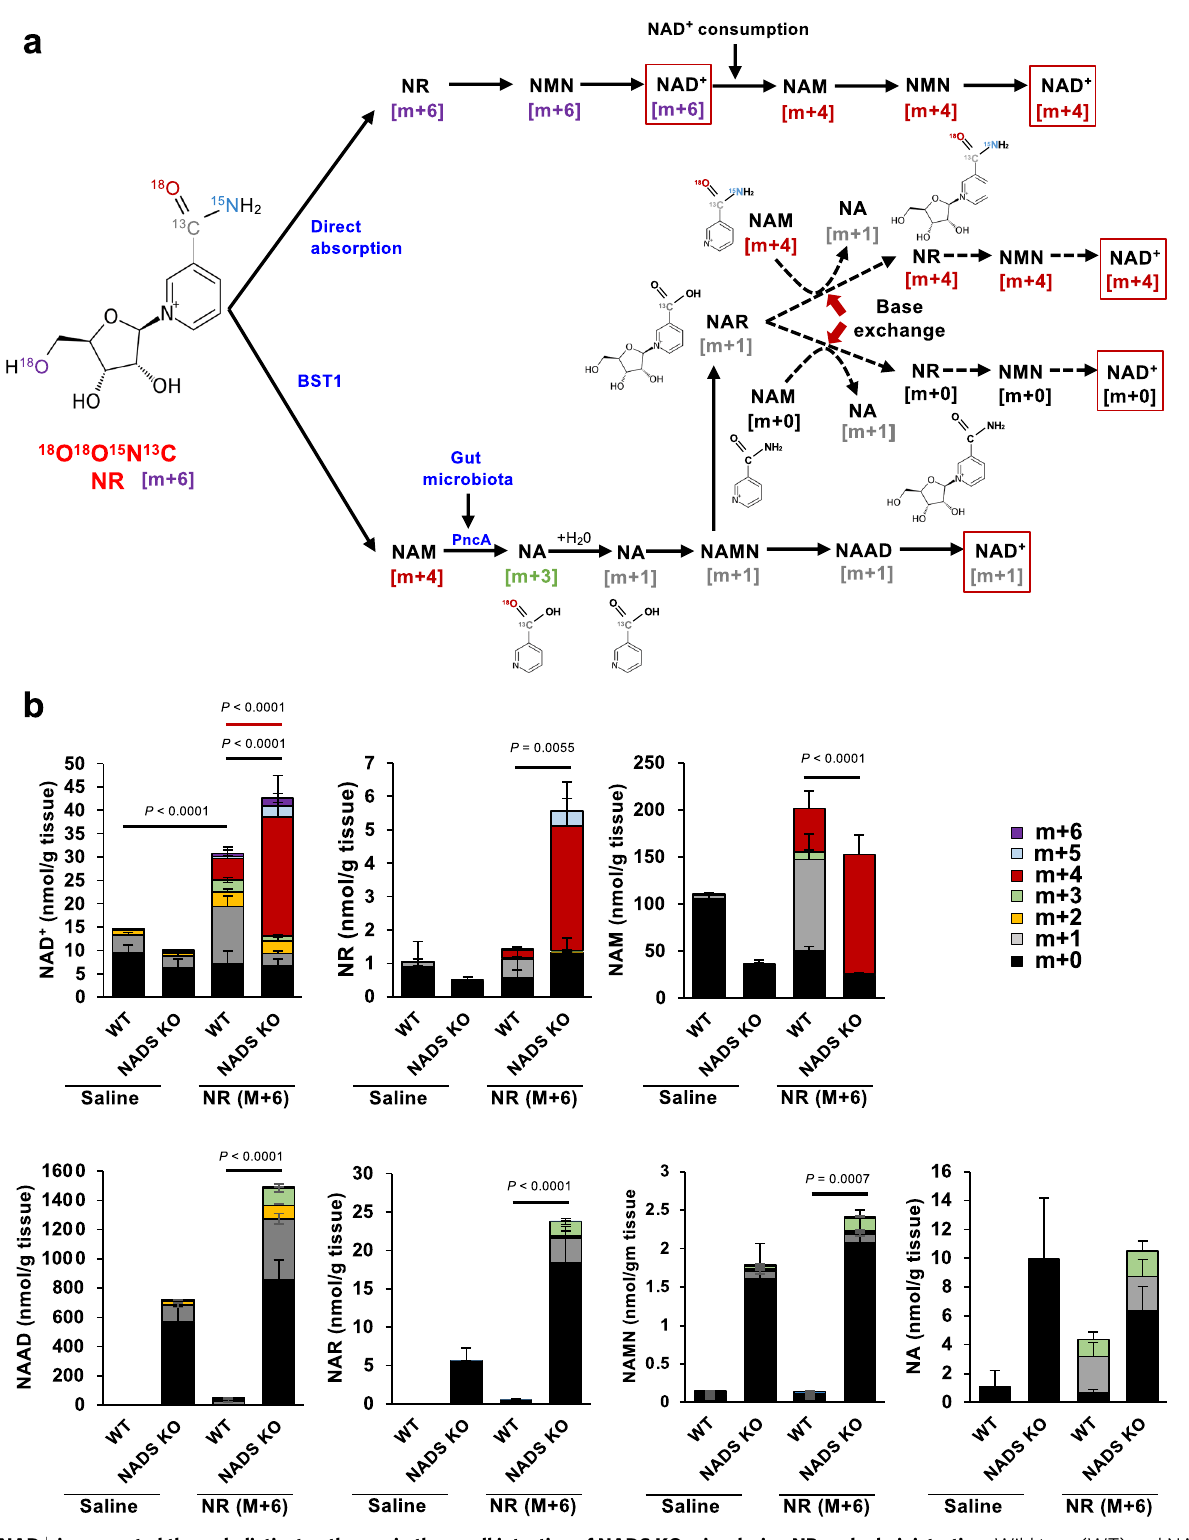
Fig. 7 NAD + is generated through distinct pathways in the small intestine of NADS KO mice during NR oral administration. Wild type (WT) and NADS KO mice were gavaged with quadruple-labeled NR, then were killed after 3 h of the gavage. a Scheme showing formation of isotope-labeled NAD + metabolites after the oral administration of quadruple-labeled NR in the small intestine. b Concentration of unlabeled (m + 0) and labeled (m + 1, m + 2, m + 3, m + 4, m + 5 and m + 6) NAD + metabolome in the small intestine was measured by LC/MS 3 h after the gavage of quadruple-labeled NR ( n = 6 mice per group). Black and red lines indicated statistical analysis for m + 1 and m + 4 labeled metabolites, respectively. Data are shown as mean ± S.D. Statistical signi fi cance was determined by One-way ANOVA followed by Tukey ’ s post-hoc tests. Source data are provided as a Source Data fi